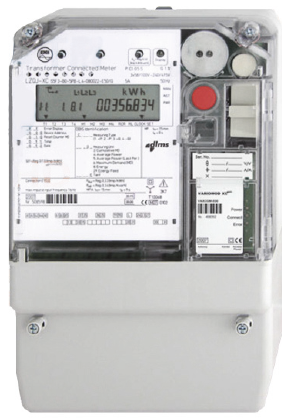
Figure 4: Smart-meter LZQJ